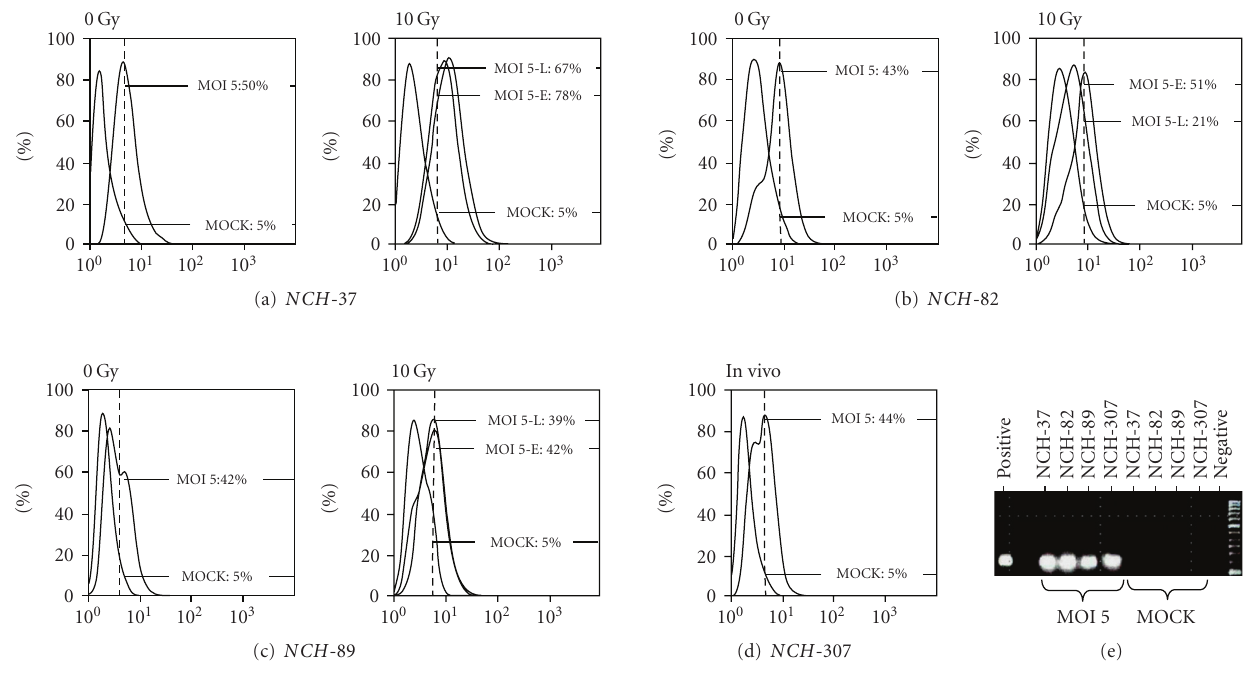
Figure 4: Replication of parvovirus H-1 (H-1PV) in irradiated human high-grade glioma cells. FACS analysis of intracellular cytotoxic parvoviral protein NS-1 in short-term cultures of human gliosarcoma NCH-37 (a), human glioblastoma NCH-82 (b), and human glioblastoma NCH-89 (c) after infection with H-1PV. To analyse the influence of radiation therapy, glioma cells were irradiated with 10 Gy or transported to the accelerator but not exposed to IR (0Gy). For e arly infection experiments, cells were infected at an MOI of 5PFU/cell 24 hours post-IR (MOI 5-E) or mock-infected (MOCK); for l ate infection experiments cells were infected at an MOI of 5PFU/cell 9 days post- IR (MOI 5-L). The short-term culture of in vivo irradiated recurrent glioblastoma NCH-307 (d) was infected with an MOI of 5 PFU/cell (MOI5) or mock-infected (MOCK). All cell cultures were harvested 24 hours p.i. and the percentage of cells positive for intracellular NS-1 was determined by FACS-analysis. (e) Detection of H-1PV RNA by RT-PCR. All cell lines except for NCH-307 were irradiated with 10 Gy. 24 hours post-IR and 24 postseeding for NCH-307, respectively, cells were infected with H-1PV at an MOI of 5PFU/cell (MOI5). RNA was isolated 24 hours p.i. amplified by RT-PCR and compared with RNA of mock-infected cells (MOCK). For positive control, RNA of H-1PV infected unirradiated highly susceptible RG2 rat glioma cells was